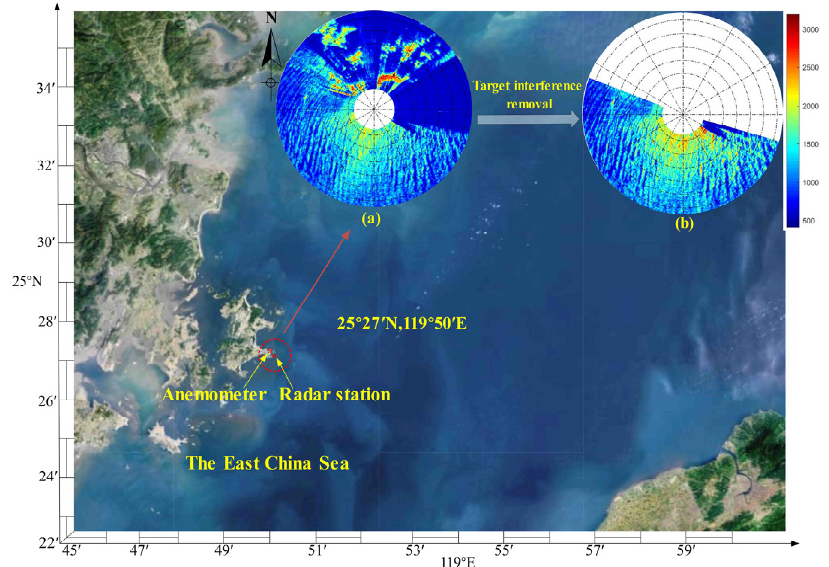
Figure 1. Map of the experiment site. Locations of the radar station and anemometer are shown by red stars. ( a ) Single polar marine radar image collected on 00:20 UTC+8 27 October 2010; ( b ) selected radar image after removing 106 ◦ ∼ − 69 ◦ amplitude on 27 October